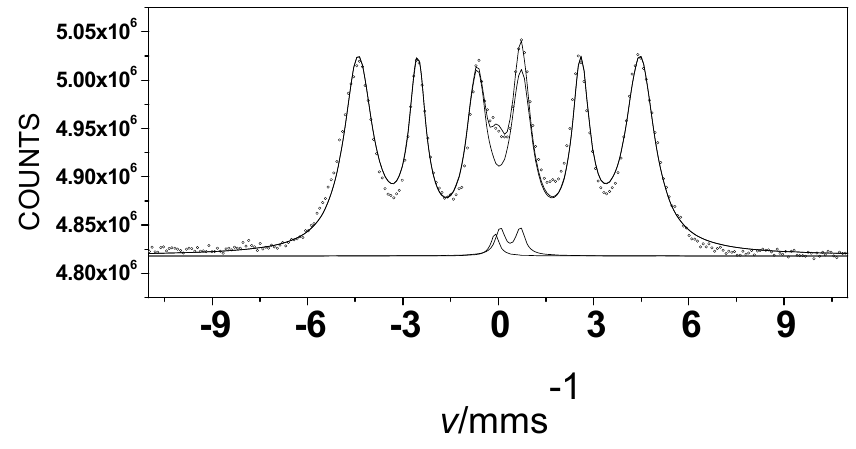
Fig. 2 M¨ossbauer spectrum of an untreated electrodeposited sample